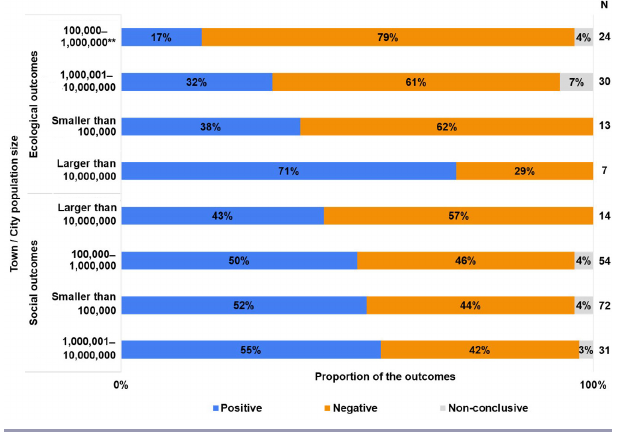
Fig. 5 . Ecological and social outcomes of urbanization on regional farming systems across population sizes of cities/towns (** Outcomes are statistically significant at p < or = 0.05).